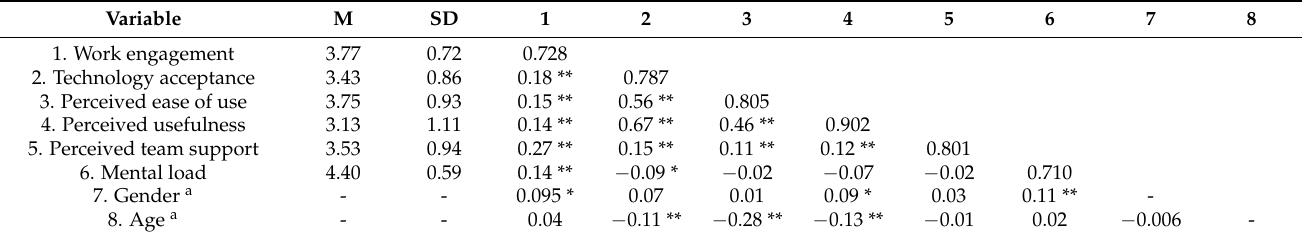
Table 3. Descriptive statistics, correlations, and discriminant validity test results.